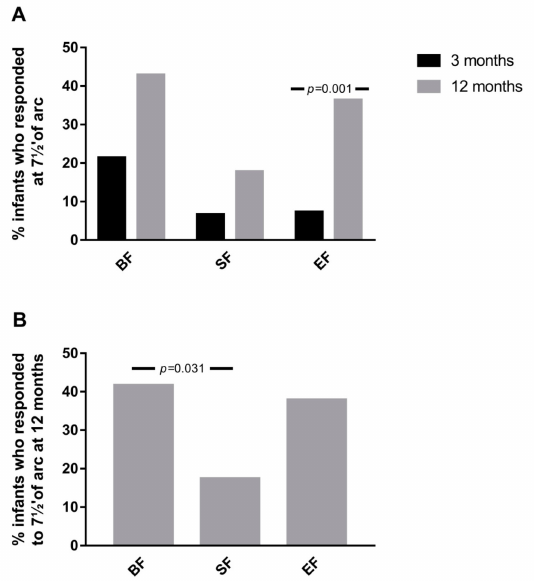
(cid:48) of arc at 12 months of age compared to 2 (cid:48) 2